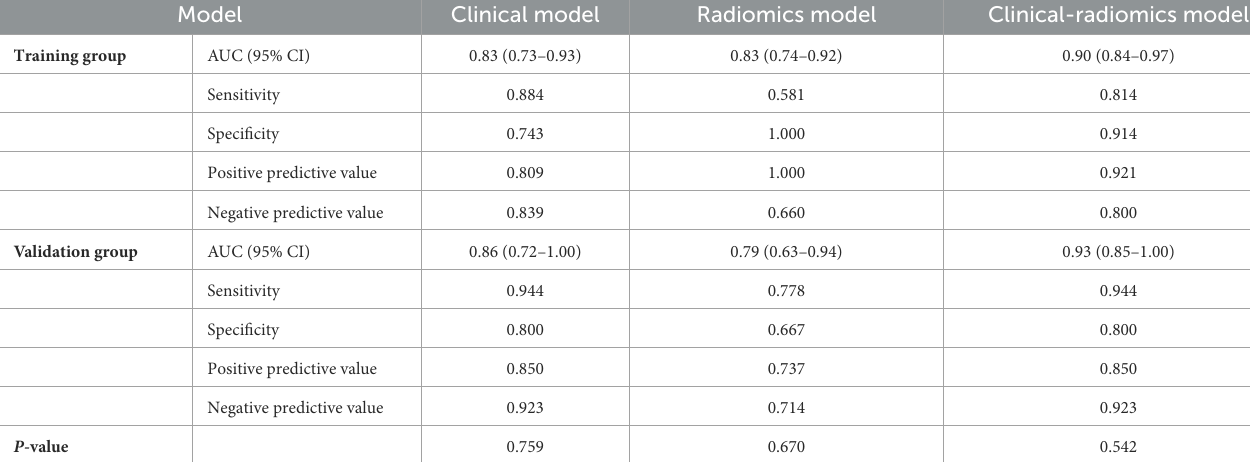
TABLE 3 ROC curves of models in the training and validation group.